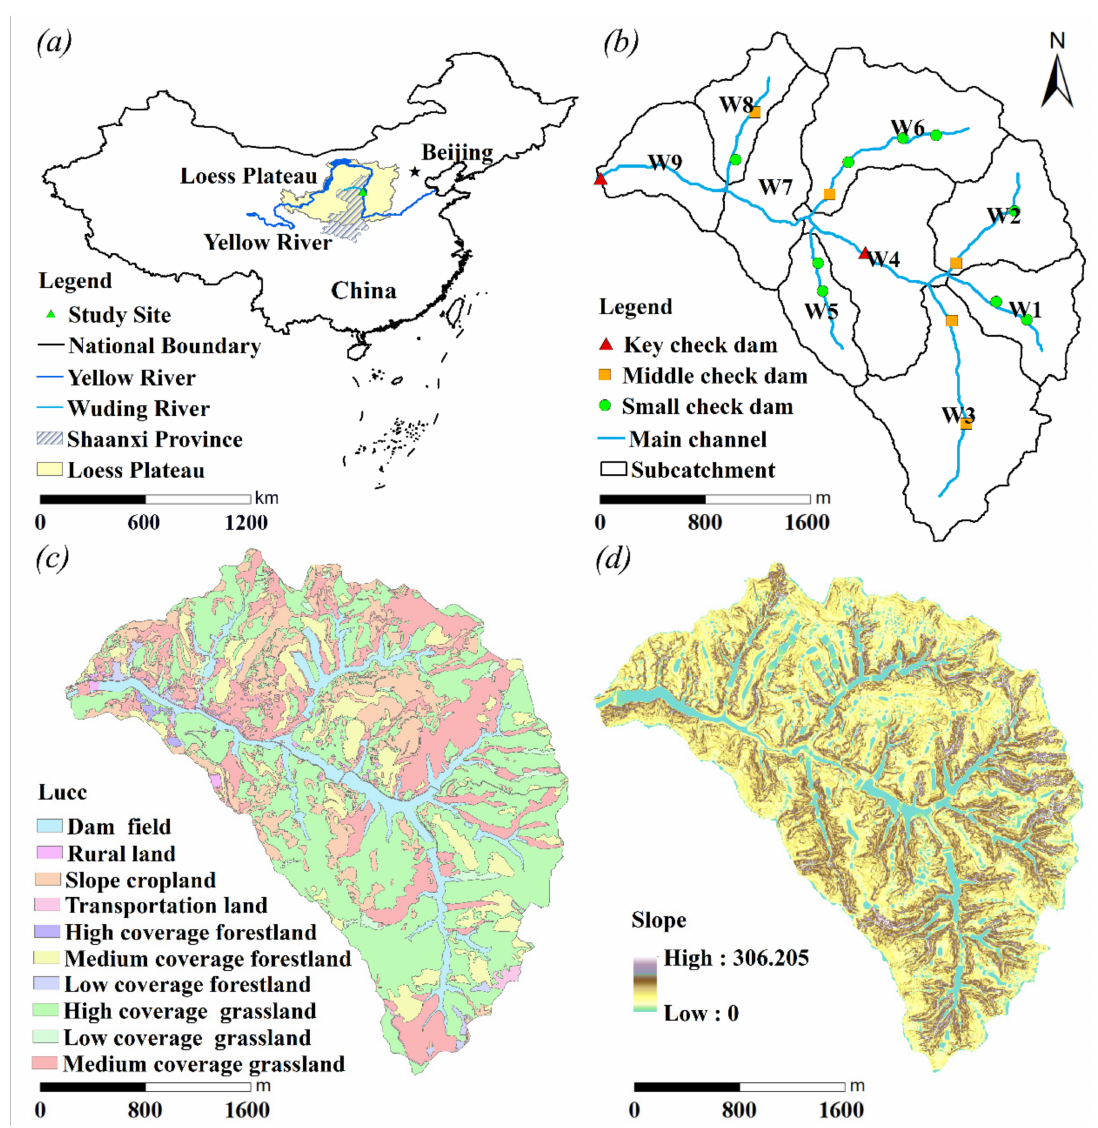
Figure 1. ( a ) Location of the study area, ( b ) check-dam distribution, ( c ) land use, and ( d )